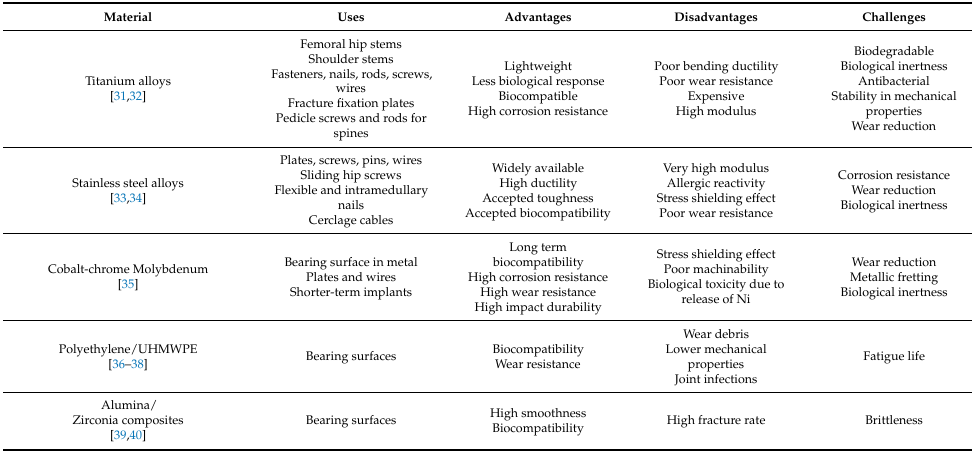
Table 1. Most common biomaterials for orthopedic